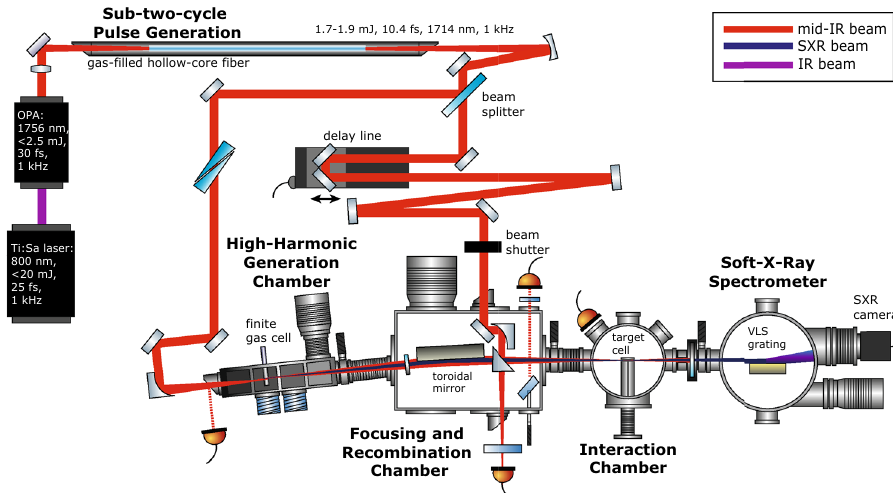
Figure 1. Experimental setup. Schematic diagram of the experimental setup for attosecond transient- absorption spectroscopy: finite gas cell (bottom left) for high-harmonic generation, pump-probe delay generation (middle), recombination, and attached interaction region (bottom middle), SXR spectrometer (bottom right). The spectrometer can be directly attached behind the recombination chamber for characterization of the generated SXR, or after the interaction region for transient-absorption